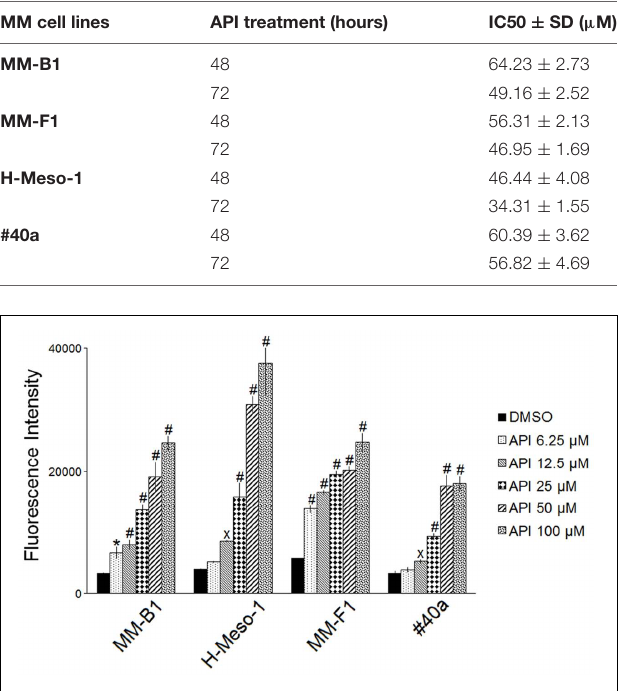
FIGURE 2 | Effect of API on the intracellular ROS production in MM cell lines. Results are reported as the mean of the fluorescence intensity ± SD values from three experiments performed in triplicate. API was used in the range 6.25–100 µ M. Statistical significance of the effects obtained with API was calculated vs. those obtained with DMSO ( x p ≤ 0.05, ∗ p ≤ 0.01, # p ≤